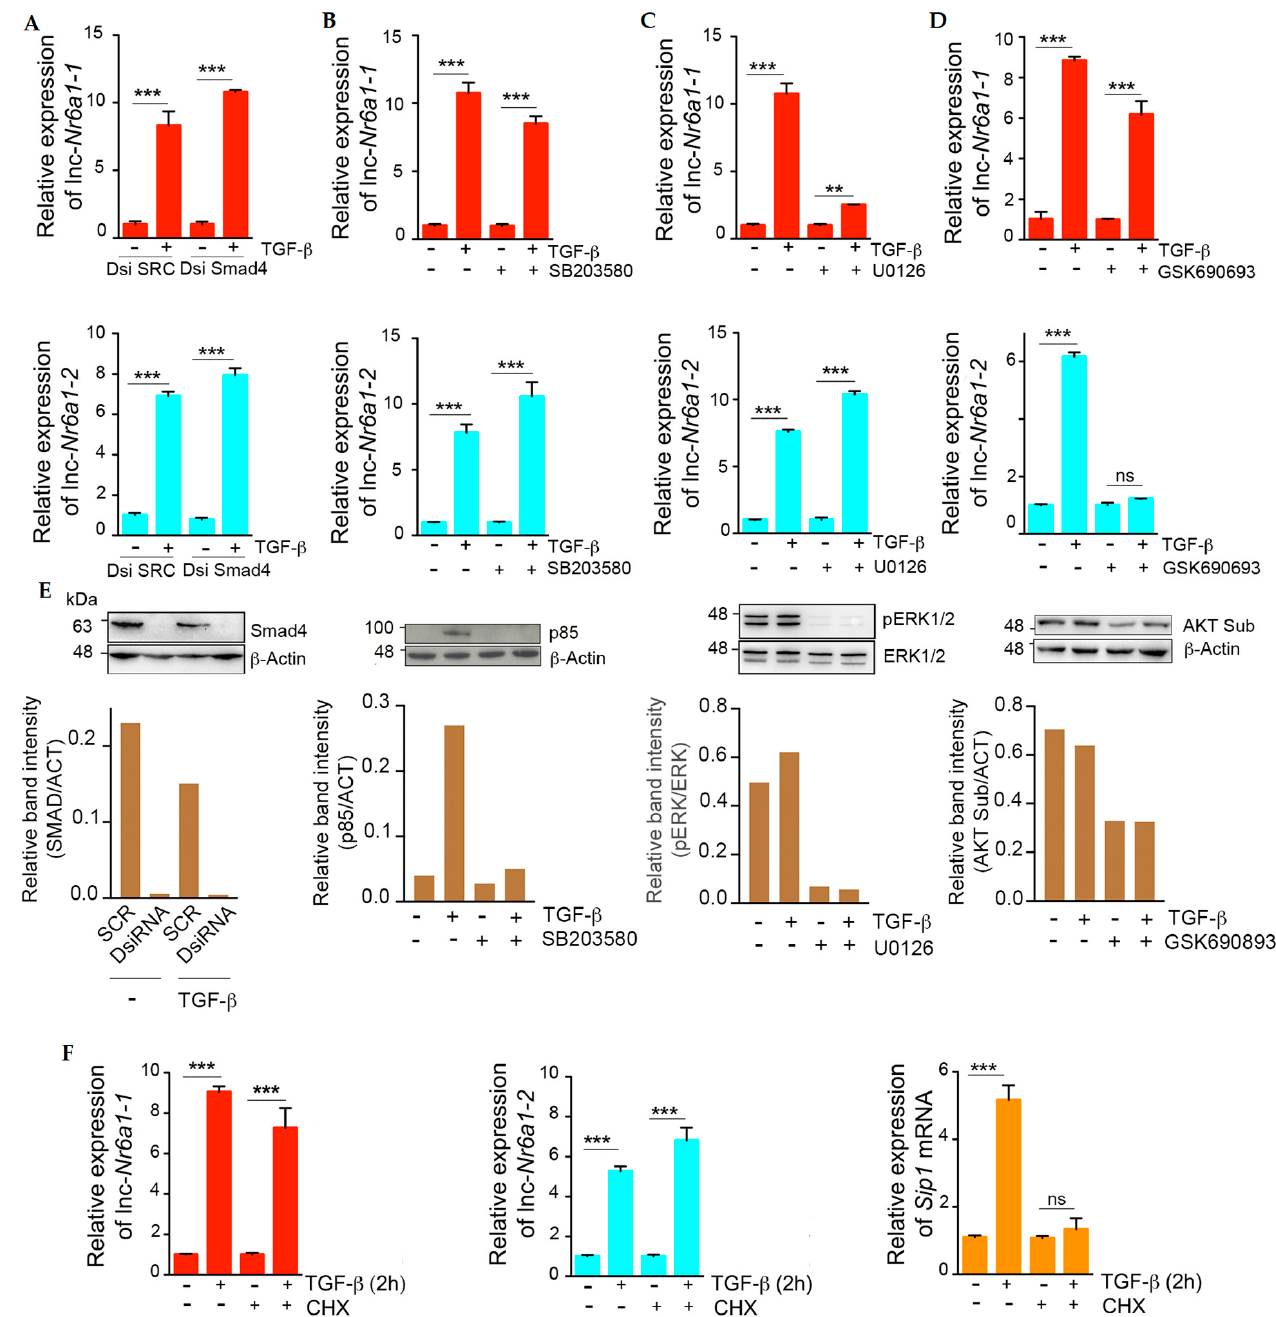
Figure 2. Signaling pathways involved in lnc- Nr6a1 isoforms upregulation by TGF- β . ( A ) NMuMG cells were transfected with DsiRNAs against Smad4 (DsiSmad4) or scramble DsiRNA (SRC) and treated with TGF- β for 2 h. Levels of lnc- Nr6a1-1 (top) and lnc- Nr6a1-2 (bottom) were measured by RT-qPCR analysis. Experiments were performed in triplicate samples; error bars represent S.D. ( B ) Effect of p38 kinase inhibitor, SB203580, on lnc- Nr6a1 isoforms upregulation. Cells were pre- treated with 10 µ M inhibitor for 1 h and next treated with TGF- β for 2 h where indicated. Levels of lnc- Nr6a1-1 (top) and lnc- Nr6a1-2 (bottom) were measured by RT-qPCR analysis. Experiments were performed in triplicate samples; error bars represent S.D. ( C , D ). Effect of MAP kinase inhibitor U0126 and AKT inhibitor GSK690693, respectively, on lnc- Nr6a1 isoforms upregulation. NMuMG cells were pre-treated with 10 µ M inhibitor for 1 h prior to addition of TGF- β for 2 h where indicated. Levels of lnc- Nr6a1-1 (top) and lnc- Nr6a1-2 (bottom) were measured by RT-qPCR analysis. Experiments